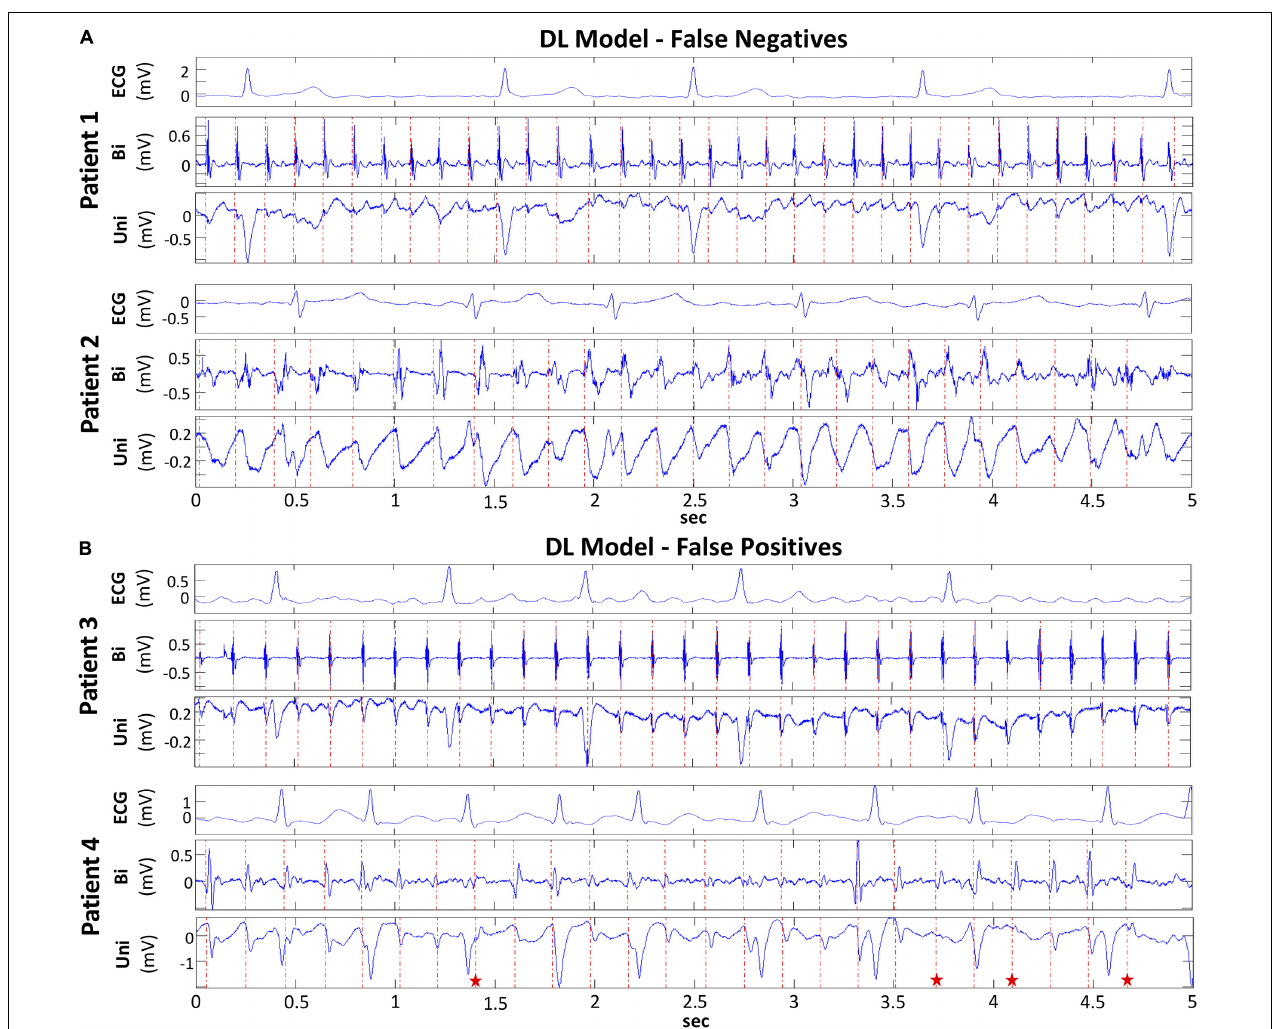
FIGURE 5 | False Classification of FaST and non-FaST using DL Model. (A) False negative classification of FaST using DL due to low-amplitude, sustained periodic unipolar QS complexes near PV ostium (Patient 1, top panel) and broad, slurred unipolar QS complexes (Patient 2, bottom panel). (B) False positive classification of FaST using DL due to sustained unipolar rS complexes with small r waves (Patient 3, top panel) and near-sustained periodic unipolar QS complexes (red stars – rS complexes) (Patient 4, bottom panel).